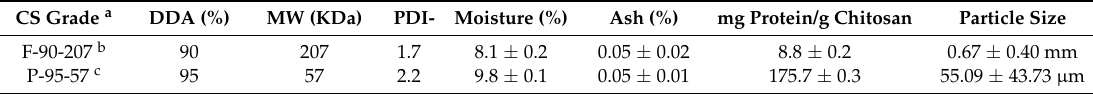
Table 1. Chitosan